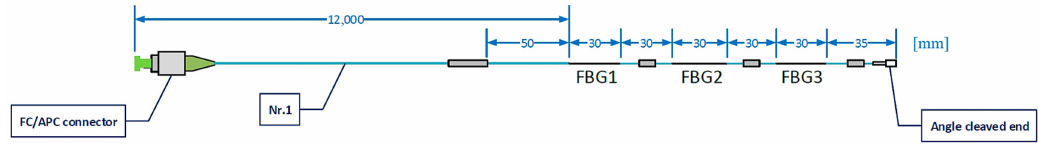
Figure 4. FBG optic fiber sensor—a